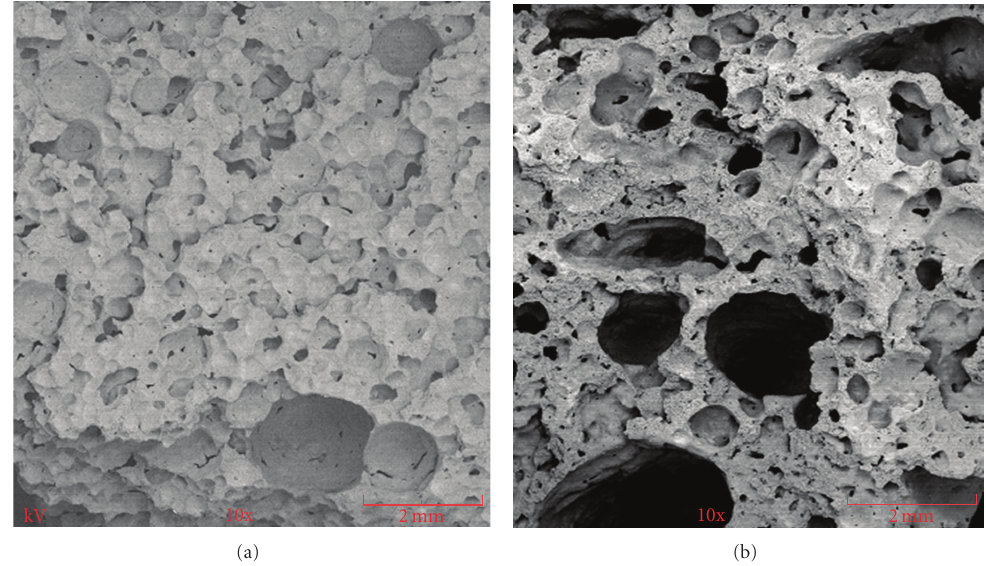
Figure 2: Fracture surfaces of samples with (a) the lowest (0.2 wt%), and (b) the highest (0.8 wt%) aluminum